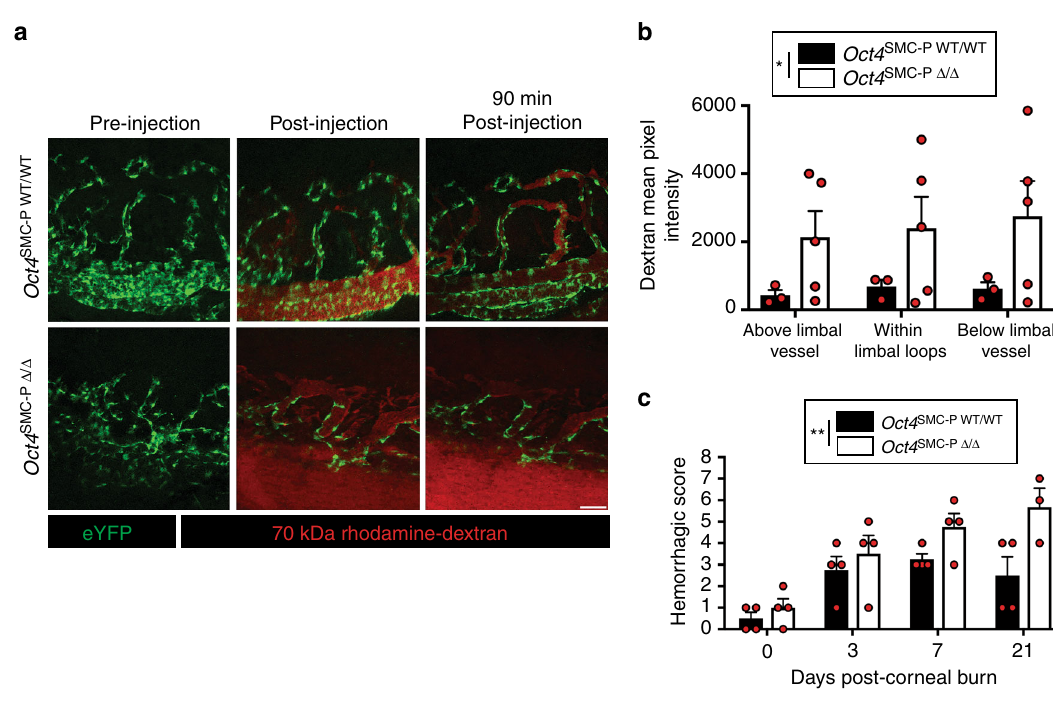
Fig. 4 SMC-P knockout of Oct4 resulted in increased vascular leak and hemorrhaging following corneal burn. a Representative still-frame images of Oct4 SMC-P WT/WT and Oct4 SMC-P Δ / Δ corneas pre-injection, immediately post-injection, and 90 min post-injection of 70 kDa rhodamine – dextran (red). Native eYFP expression is shown in green. b Quanti fi cation of dextran mean pixel intensity of de fi ned regions throughout the vascular network ( n = 3 WT, 5 KO). Scale bar = 50 μ m. c Quanti fi cation of hemorrhaging and cornea integrity at each time point post-corneal burn ( n = 4 WT, 4 KO for D0, D3, D7; n = 4 WT, 3 KO for D21). Values = mean ± s.e.m. Statistics were performed using two-way ANOVA ( b , c ). * P < 0.05 and ** P < 0.01